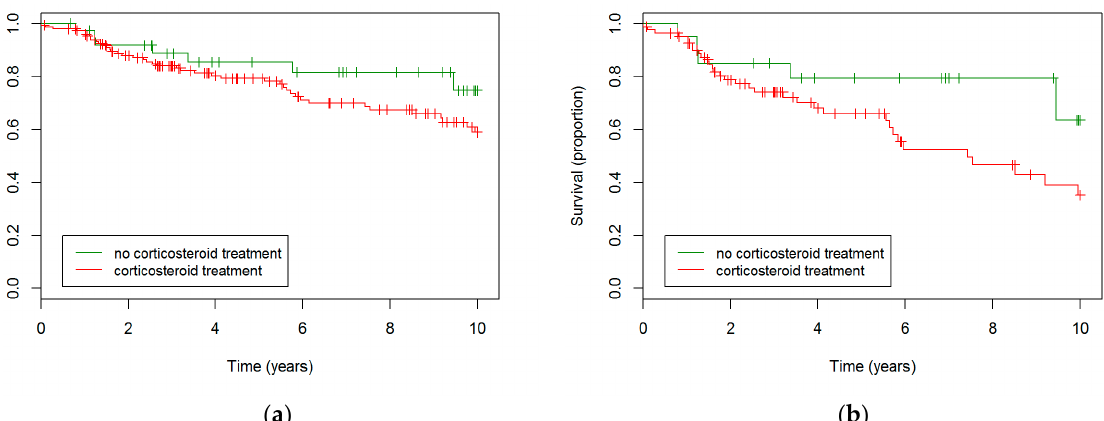
Figure 2. Survival in corticosteroid-treated patients compared to never-treated patients. ( a ) Kaplan Meier based on the entire cohort. No statistically significant differences were observed. ( b ) Kaplan Meier based on the fHP subgroup. A trend towards worse survival in the treated group was observed ( p = 0.096).